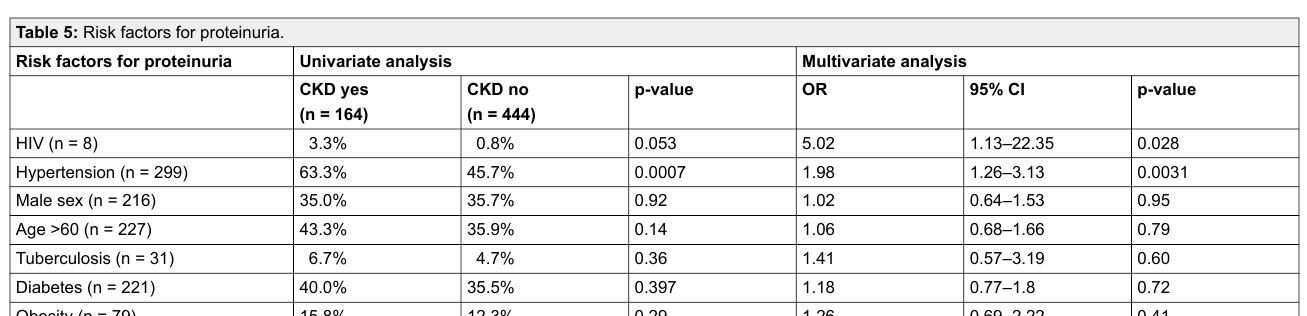
Table 5: Risk factors for